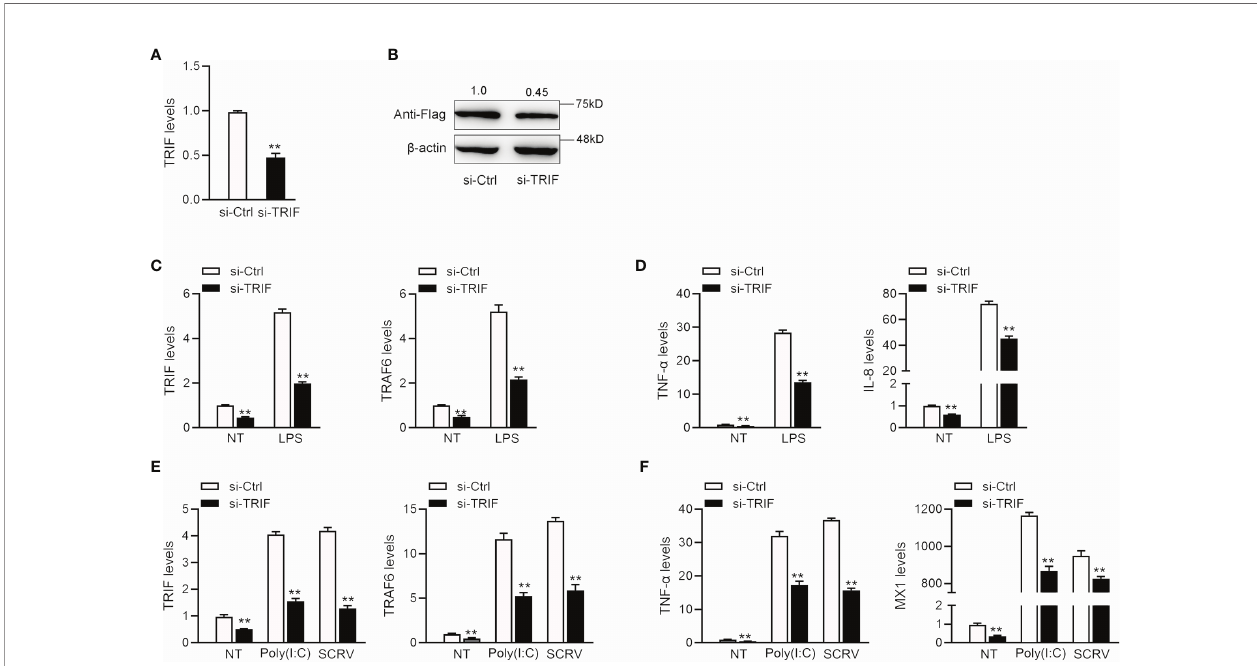
FIGURE 6 | The expression levels of in fl ammatory cytokines after TRIF interference. (A) si-TRIF or si-NC were transfected into miiuy croaker MBrC cells, after 48 h, TRIF mRNA expression was measured. (B) TRIF expression plasmids, si-TRIF and si-NC were transfected into HEK293 cells, after 48 h, TRIF protein expression was measured by western blotting. (C) si-TRIF or si-NC were transfected into MBrC cells with LPS stimulation, after 48 h, TRIF and TRAF6 mRNA expression were measured by qRT-PCR. (D) si-TRIF or si-NC were transfected into MBrC cells with LPS stimulation, after 48 h, TNF- a and IL-8 mRNA expression were measured by qRT-PCR. (E) We transfected si-TRIF or si-NC into miiuy croaker MBrC cells with poly(I:C) stimulation or SCRV injection, TRIF and TRAF6 mRNA expression were tested by qRT-PCR. (F) We transfected si-TRIF or si-NC into miiuy croaker MBrC cells with poly(I:C) stimulation or SCRV injection, TNF- a and IL-8 mRNA expression were tested by qRT-PCR. All data are presented as the means ± SE from three independent triplicate experiments. ** p < 0.01 versus the